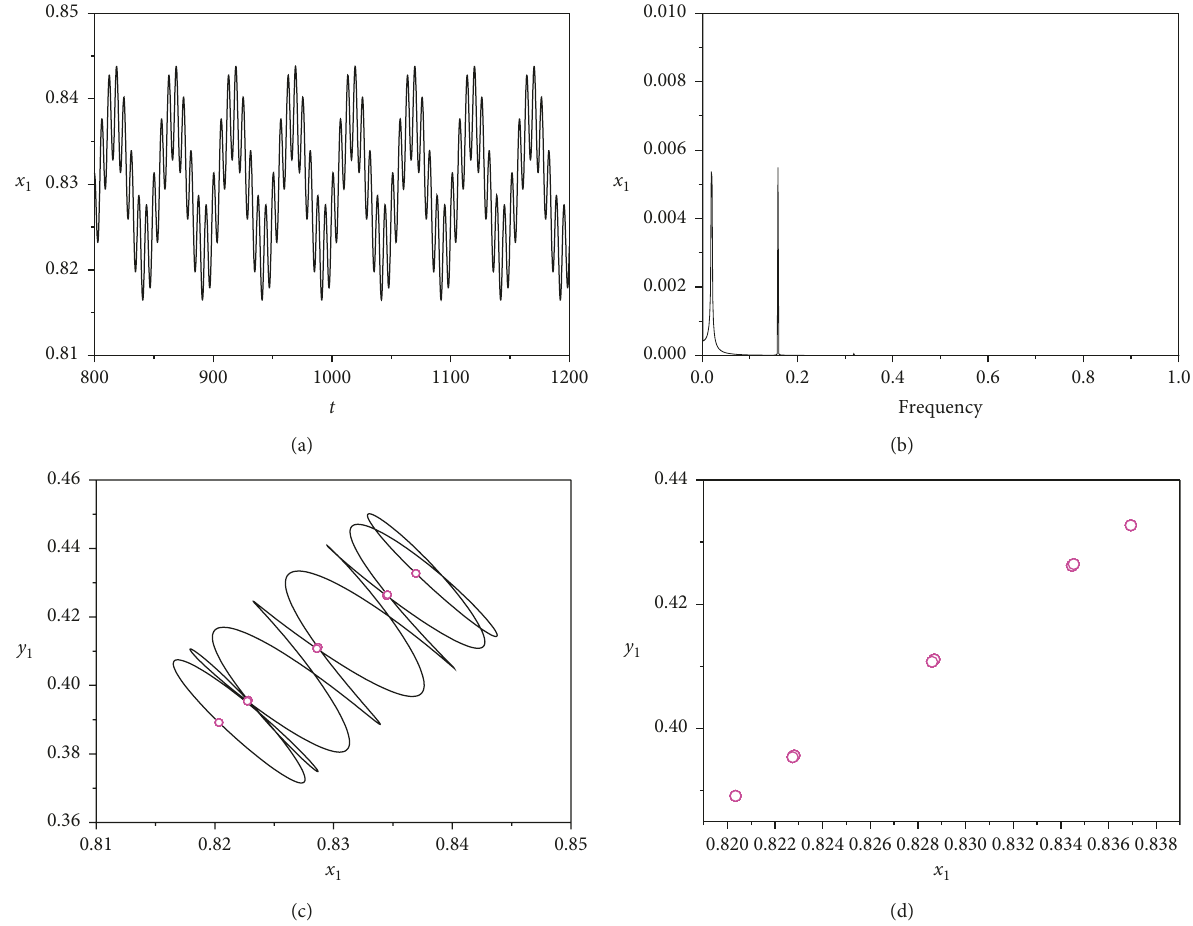
Figure 11: ω � 1.20 and η � 0.125: (a) displacement response; (b) frequency spectrum; (c) rotor orbit; (d) Poincar´e maps.